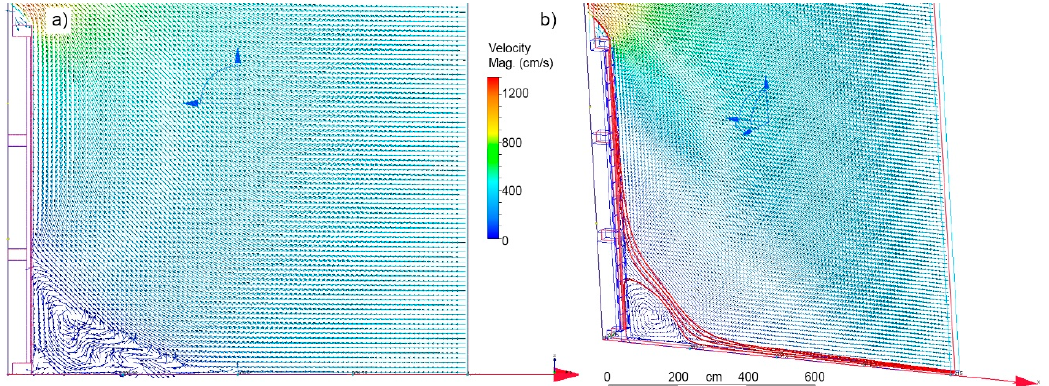
Figure 3. Speed and direction of the air in its encounter with the building: ( a ) Model elevation and ( b ) perspective.